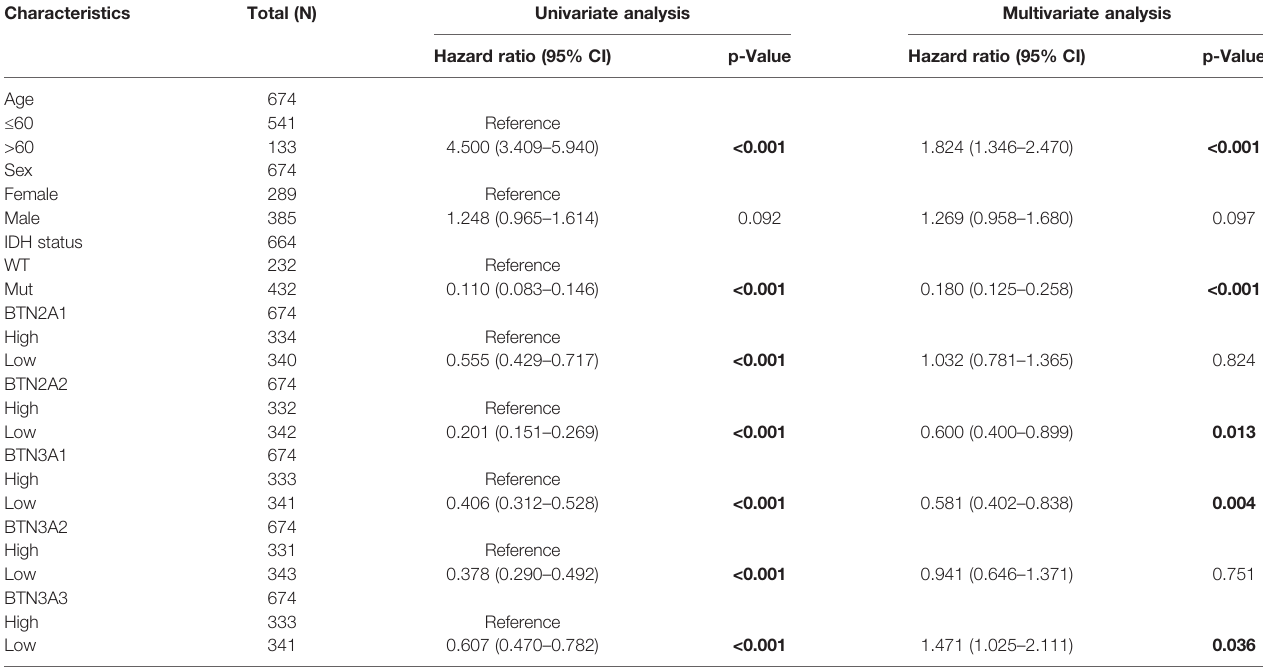
TABLE 3 | Univariate and multivariate analyses of the correlation of BTN2/3 subfamily mRNA expression with DSS among GBMLGG patients.